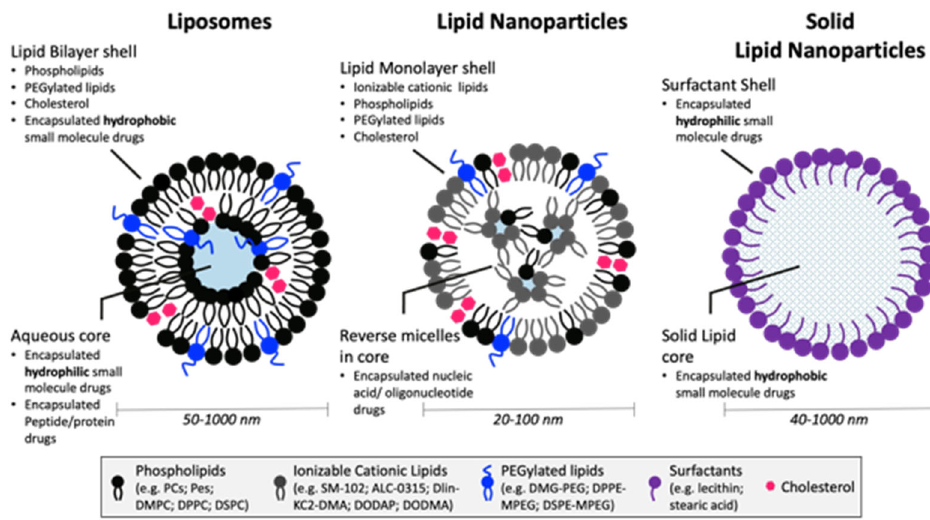
Figure 1. Types of LBNPs utilized in micro fl uidic production